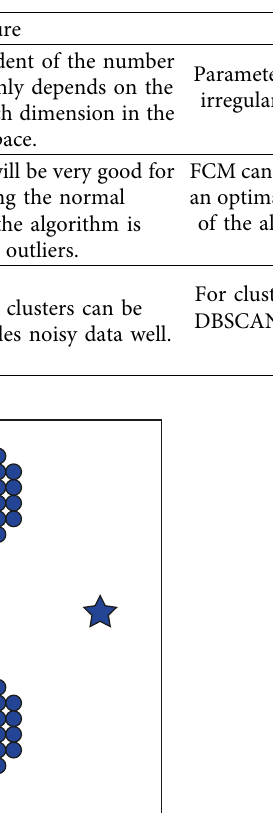
Figure 2: Overview of the system architecture. Table 1: Comparison between K -means and other clustering algorithms.